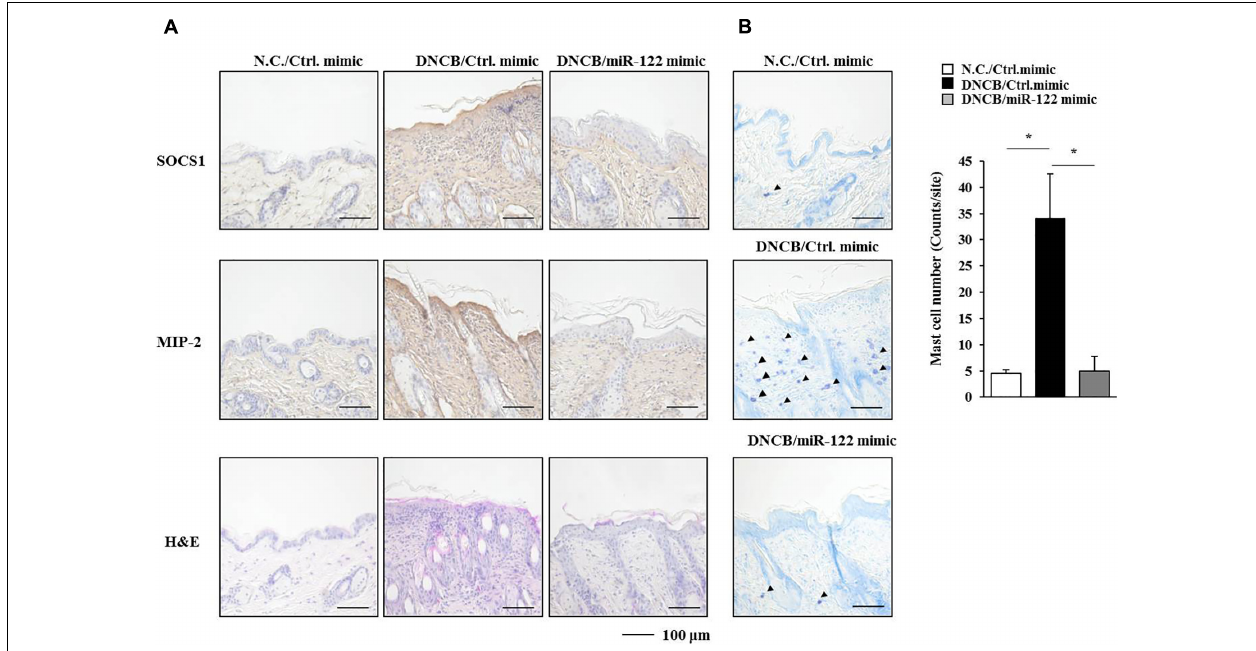
FIGURE 9 | miR-122a-5p mimic negatively regulates the expression of SOCS1, MIP-2, and the number of degranulated mast cells. (A) Immunohistochemical staining by employing the indicated antibody was performed. Scale bar represents 100 µ m. H&E staining was also performed. (B) Skin tissues of BALB/c mice of each experimental group were isolated at the time of sacrifice and were subjected to toluidine blue staining to determine the number of degranulated mast cells. Closed triangle represents degranulated mast cells. Scale bar represents 100 µ m. ∗ p < 0.05.